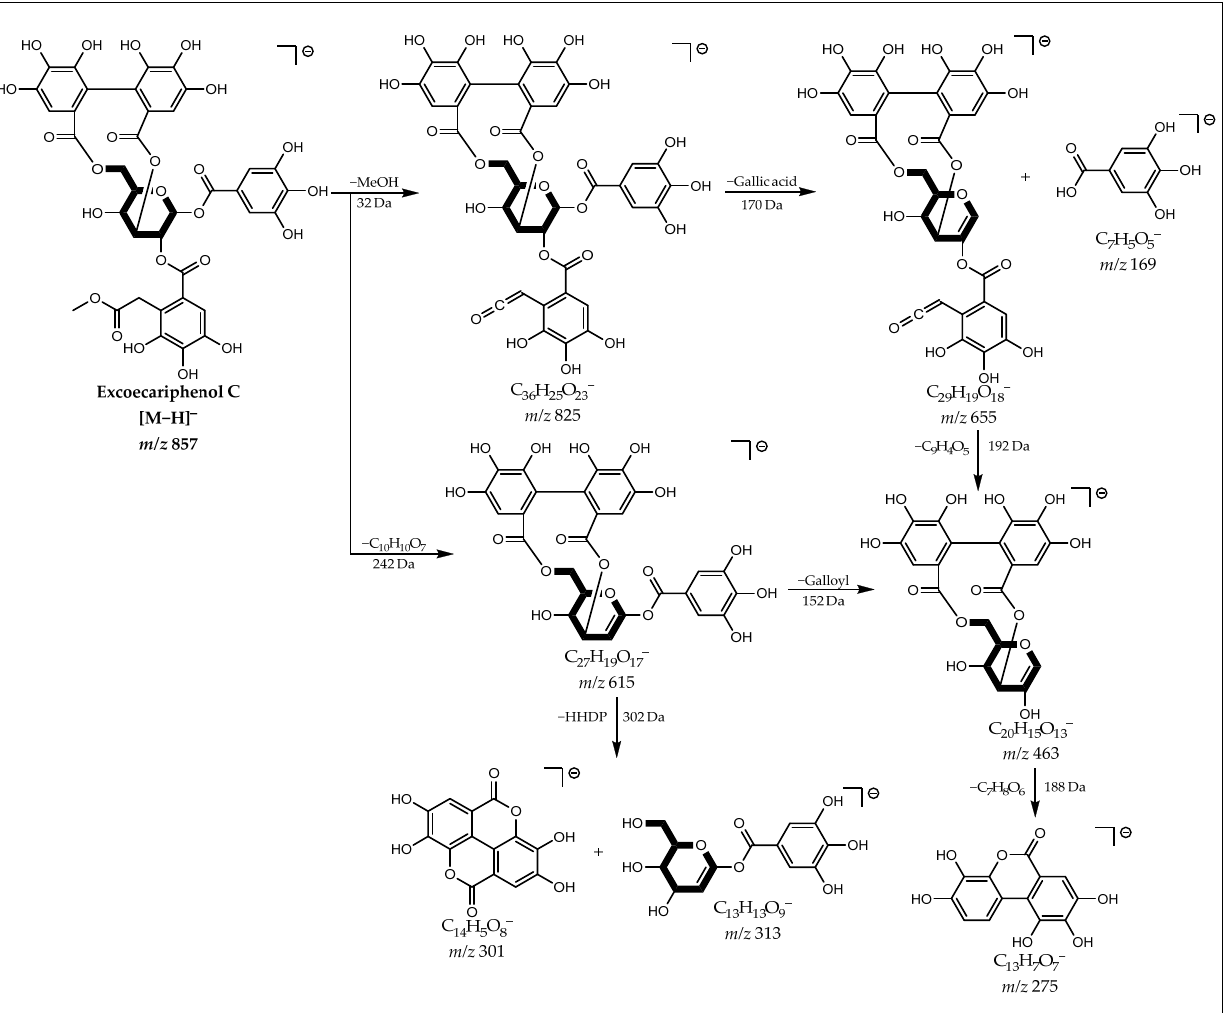
Figure 4. Proposal for fragmentation of Excoecariphenol C Isomer.